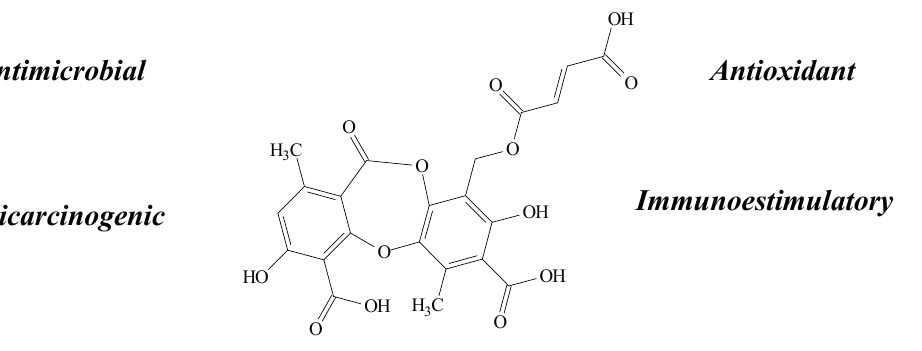
Figure 8. Fumarprotocetraric acid structure and biological activities.